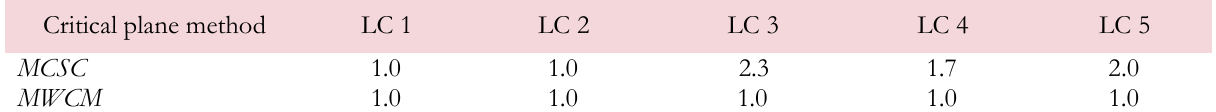
Table 3b: Normalized effect of stress multiaxiallity on fatigue damage predicted using selected multiaxial fatigue methods – Comparison between the different